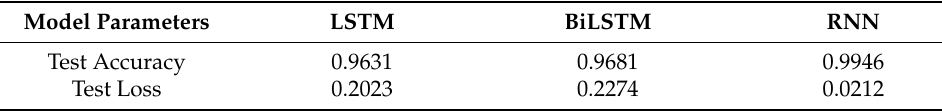
Table 5. Proposed models evaluation summary